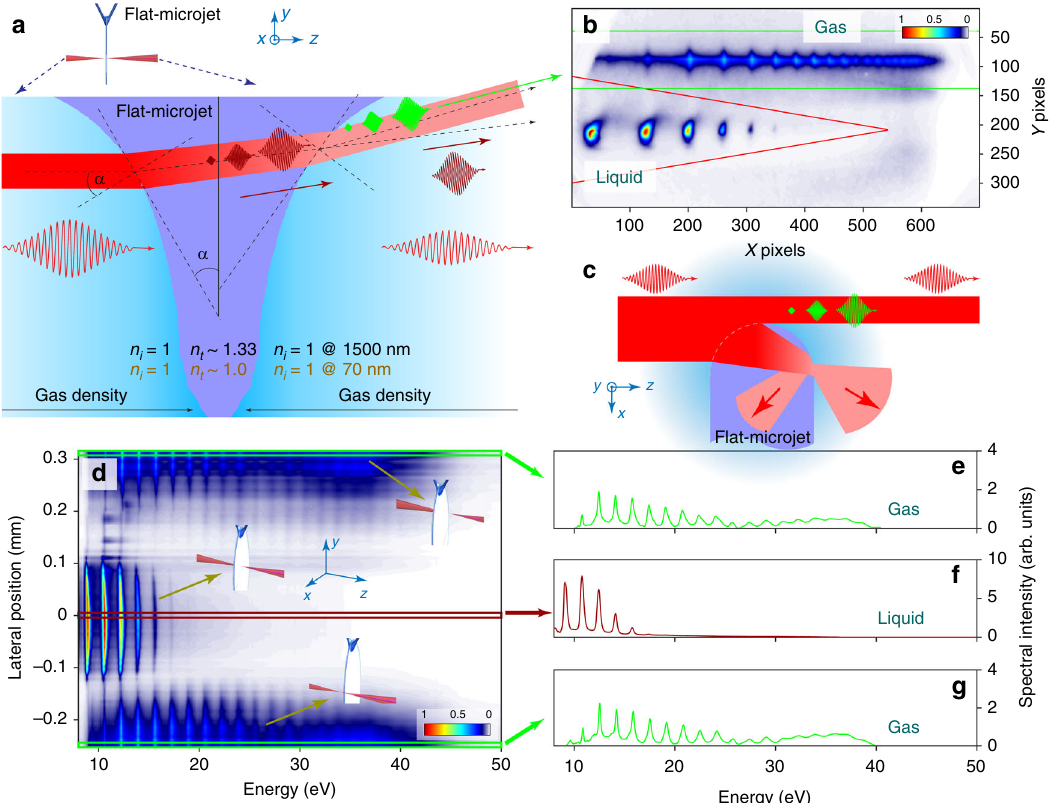
Fig. 6 Separating HHG from liquid and gas. a Schematic illustration of the optical path of the infrared laser pulses through the liquid fl at microjet. The EUV emission from the bulk liquid is not refracted as it leaves the jet because the change in refractive index n i,t (i: incident, t: transmitted) is negligible, in contrast to the driving infrared beam that is strongly refracted, resulting in b , spatial separation of the emissions from the liquid and gas phases. The red and green lines delineate the areas of integration. c , Illustration of the laser – beam – fl at – microjet interaction at partial lateral overlap. d Typical HHG spectra integrated over the y – dimension of the detector, obtained by scanning the jet position in the x – dimension. Inset drawings illustrate where the laser beam hits the fl at – microjet spatially. e – g Cross cuts of the HHG spectra when the laser beam hits the center of the fl at microjet ( f ), or the surrounding gas phase on either side of the jet ( e , g ). Note the different scales on the vertical axes. Liquid ethanol is used as a sample in all data shown here